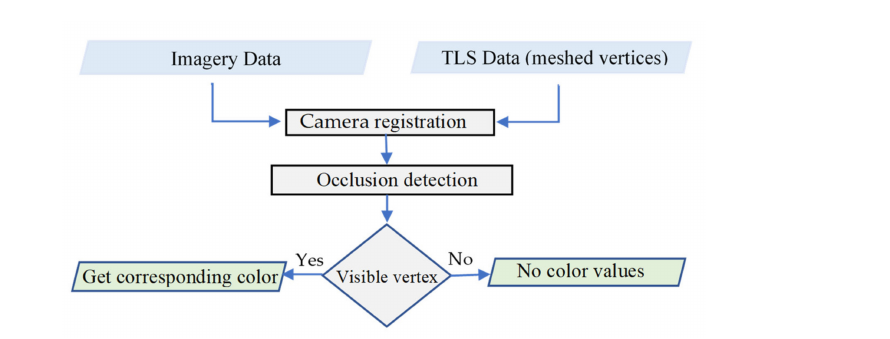
Figure 12. The flowchart of texture mapping.